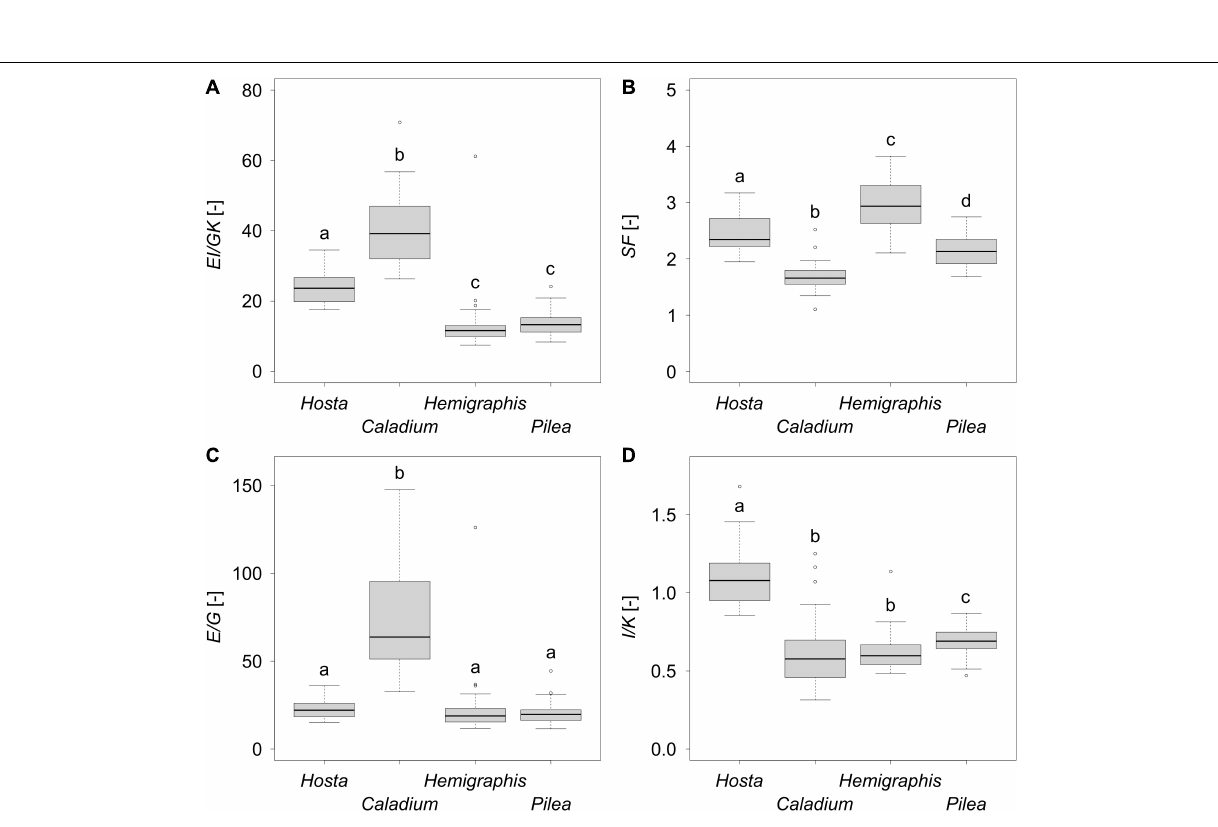
Frontiers in Plant Science |